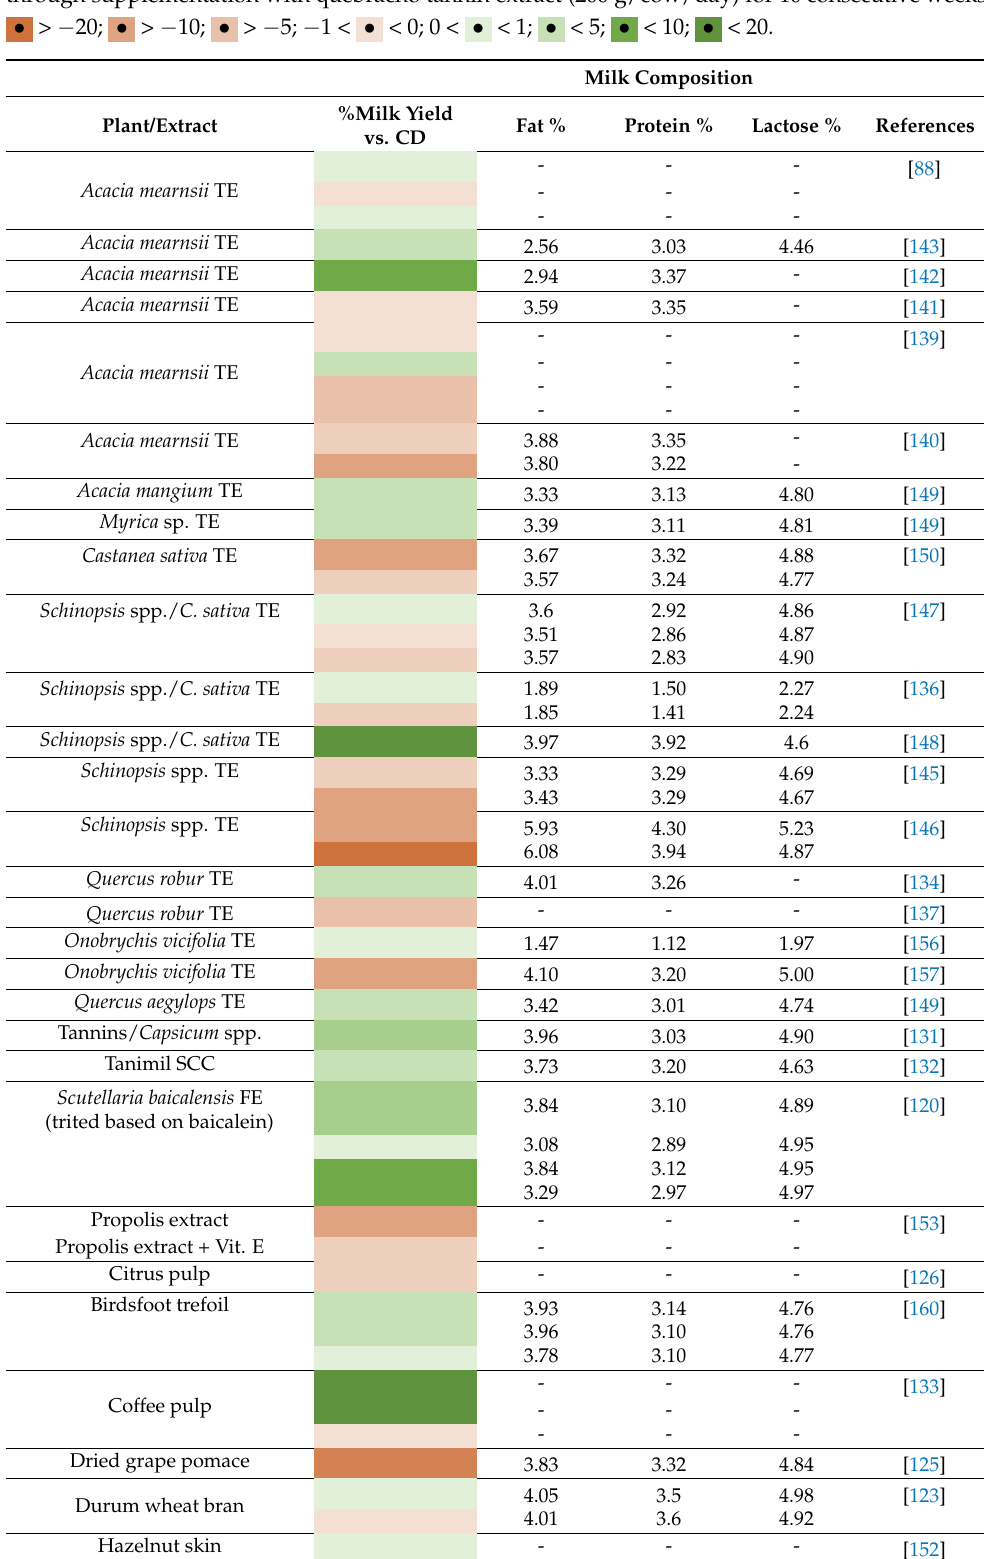
Table 1. Milk yield variation (obtained as decreased/increased percentage between milk yield of control group and treated group) and milk composition in terms of fat, protein, and lactose content (%) from different studies. The major increase in milk yield was reported by Estrada-flores et al. [133] through sup- plementation with coffee pulp (0.6% kg/DM) for 26 days, while the major decrease [146] was observed through supplementation with quebracho tannin extract (200 g/cow/day) for 10 consecutive